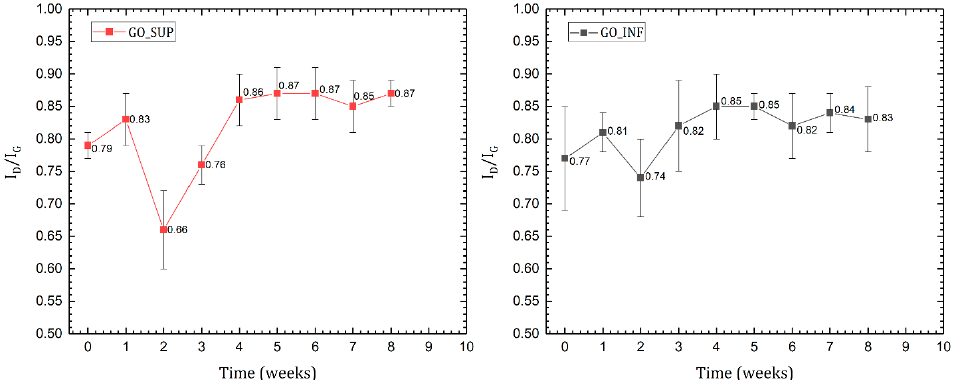
Figure 5. The time evolution of the D and G band intensity ratio from the Raman spectra of dried GO_SUP ( left ) and GO_INF ( right ) samples.